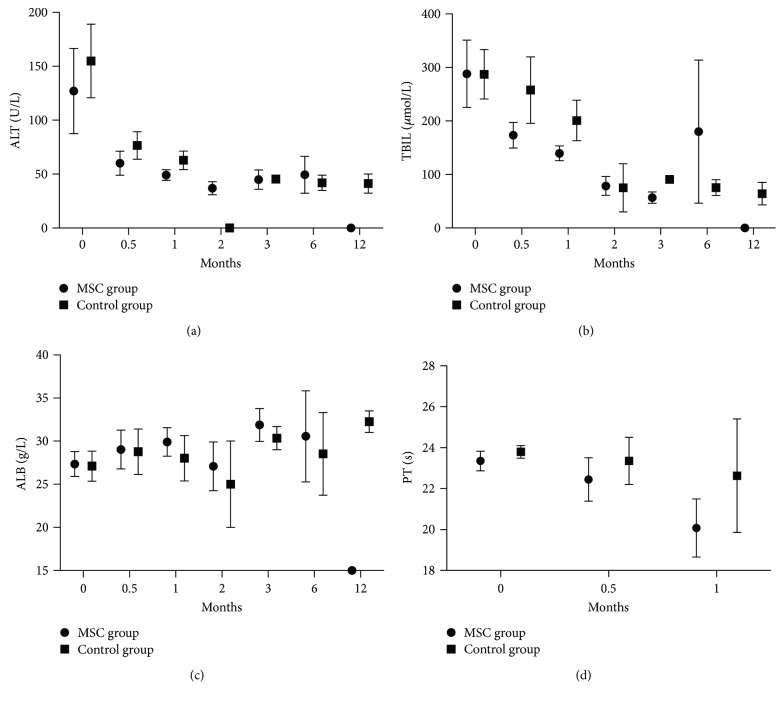
The improvement of ALT, TBIL, ALB, and PT between MSC group and control group. After MSCT, (a) the ALT baseline decreased in half a month (78.57 ± 30.23 versus 288.29 ± 140.54 μmol/L, P < 0.05); (b) the TIBL baseline diminished largely at 2 and 3 months (56.74 ± 18.40 versus 288.29 ± 140.54 μmol/L, P < 0.05); (c, d) the variations of ALB and PT at different time points had no statistical differences.